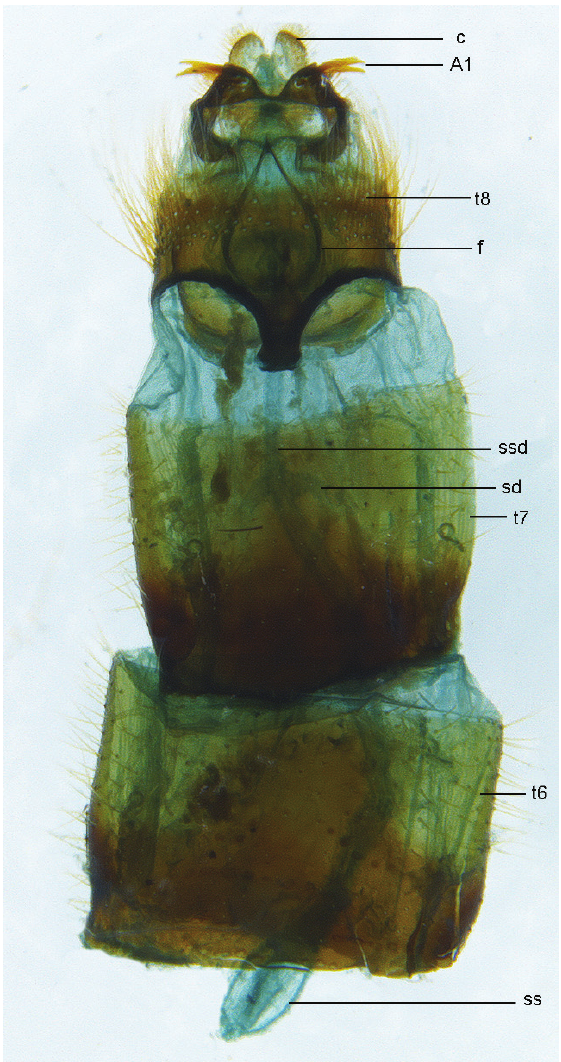
Figure 27. Zelothrix yeatesi sp. n.: Female genitalia, dorsal view. Abbreviations: c, cercus; A1 acanthophorite spines A1; t6–t8; tergites 6–8; sd , spermathecal duct; ss , spermathecal sac; ssd , spermathecal sac Zelothrix yeatesi sp. n.